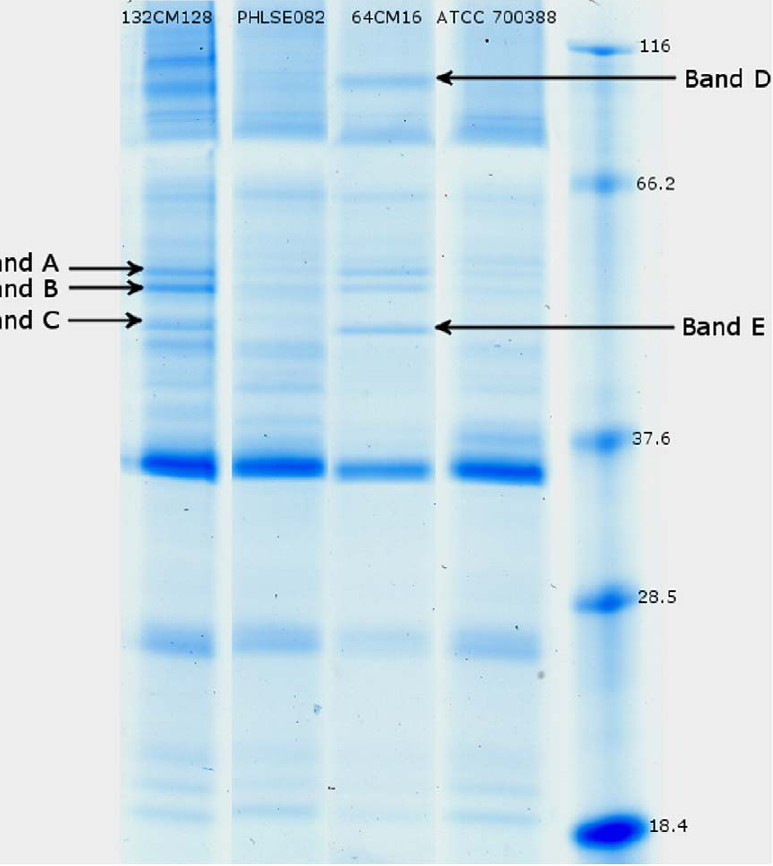
Figure 1. Analyses of the detergent-insoluble membrane proteins of chloramphenicol-resistant variants. SDS-PAGE analysis was performed on ATCC700388 and PHLSE082, two wild-type strains of B. thailandensis , and on 64CM16 and 132CM128, their respectively chloramphenicol resistant derivative strains. Proteins were stained with Coomassie blue. The variants presented different additional bands at around 51 kDa (band A), 48 kDa (band B), 43 kDa (bands C and band E) and at 95 kDa (band D). Molecular weight standards are indicated in kilodaltons.